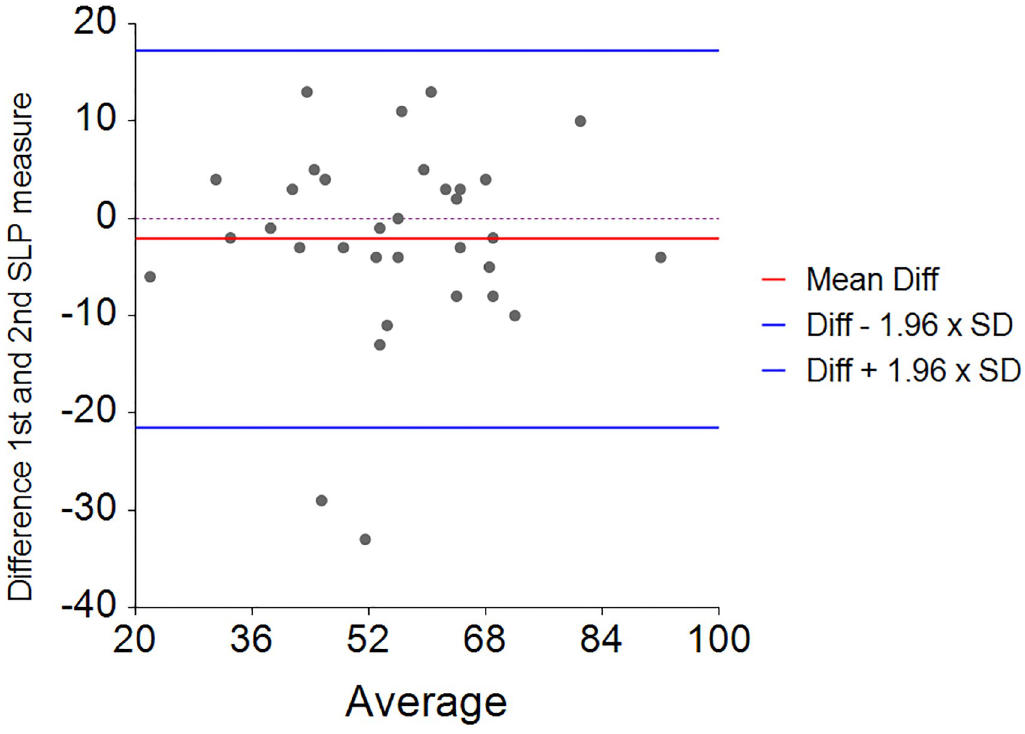
Fig 11. Bland and Altman repeatability plot of tidal breathing (SLP); 1 st minus 2nd measurement and average for percentage contribution of thoracic expansion in the patient group.